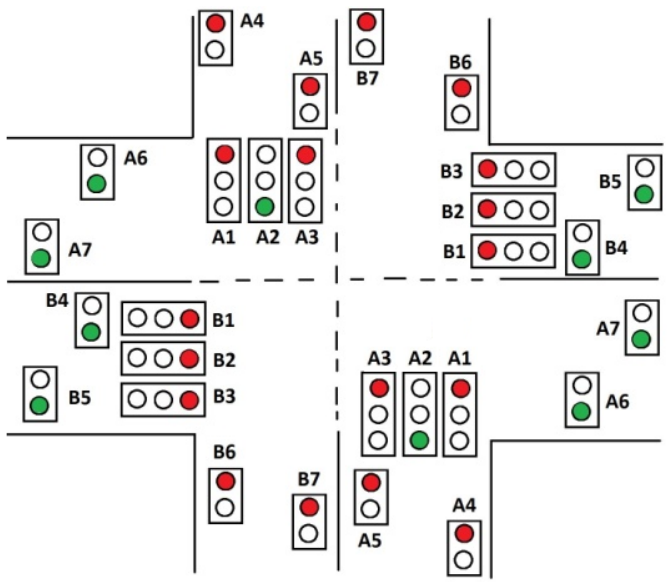
Figure 3. The idea of a crossroad traffic light system.